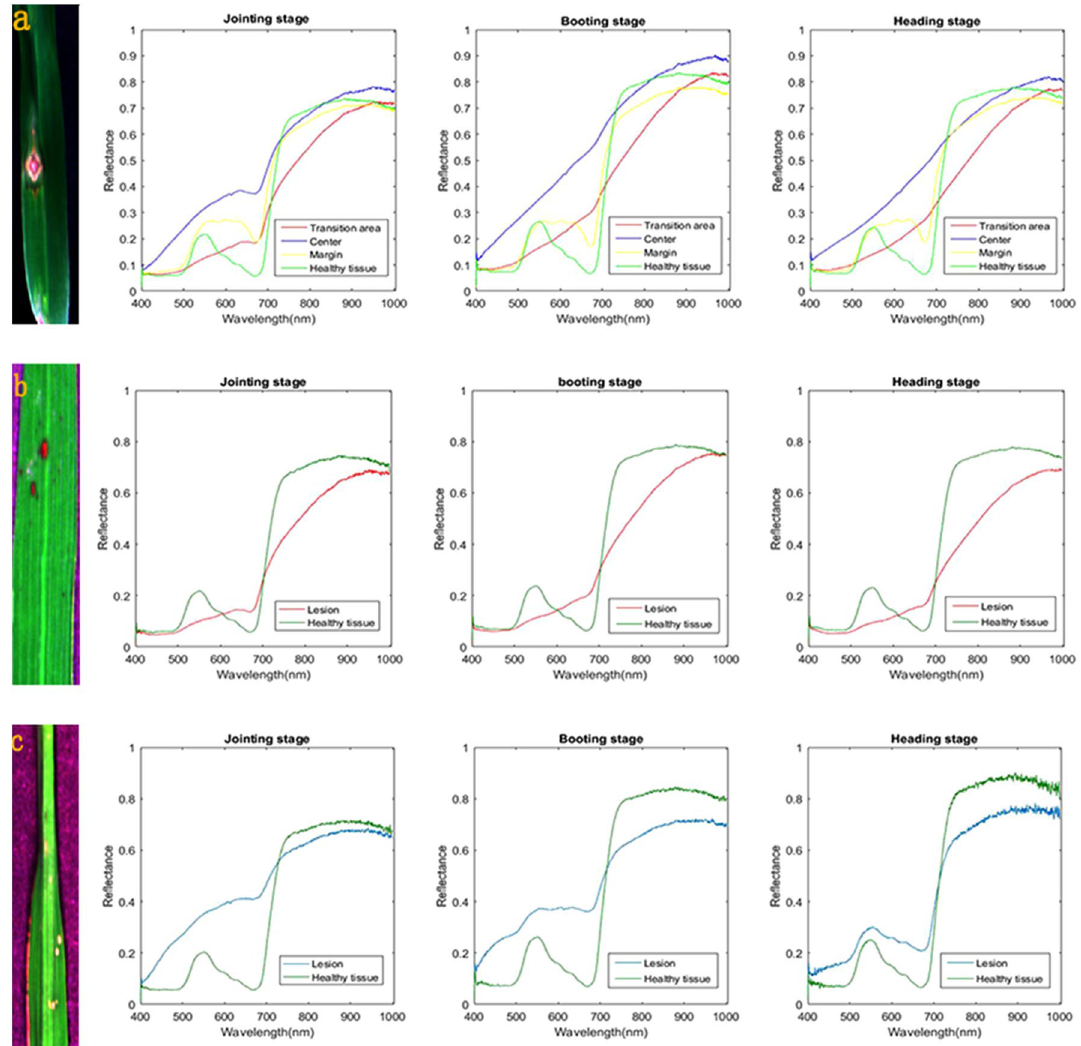
Figure 1. Spectral reflectance of leaves with different forms of lesions at different growth stages. ( a ) The chronic form; ( b ) the brown spot form; ( c ) the white spot